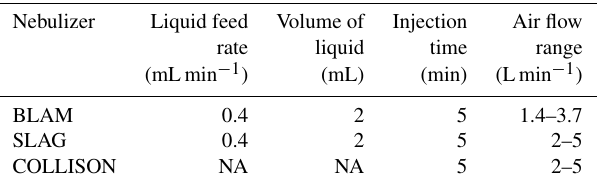
Table 1. Working conditions of each nebulizer during the tests with the liquid impinger. NA means not available.